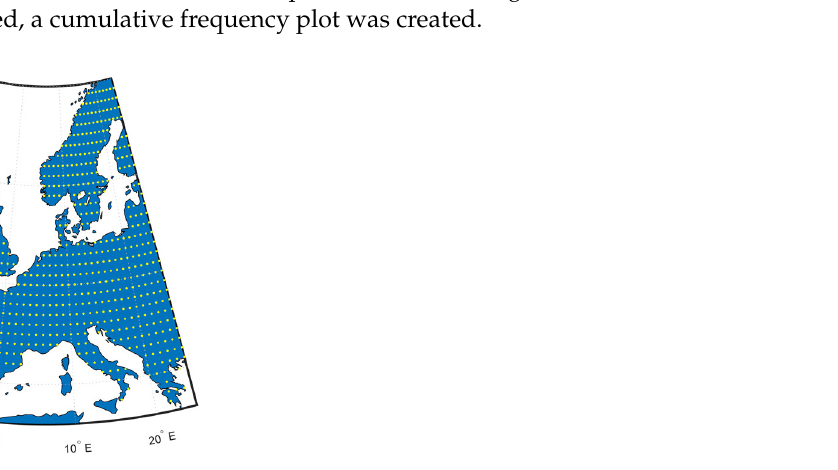
Figure 10. Exemplary visualization of investigated aircraft positions in Europe with a spacing of 1° in latitude and longitude—the calculation was carried out with a spacing of 1/60°, which results in a maximum spacing of approximately 1 NM.